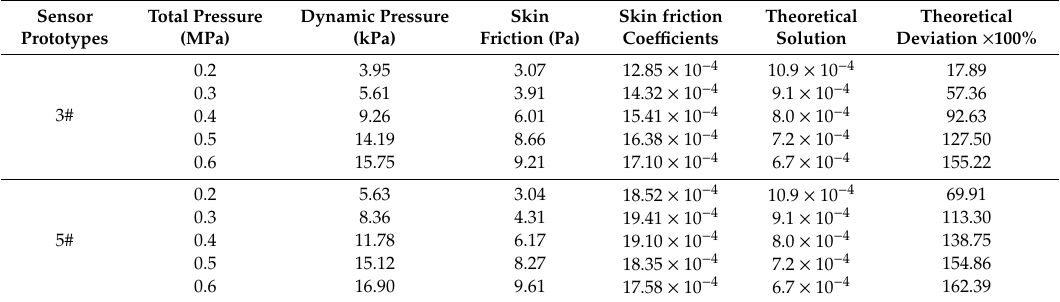
Table 7. The data analysis of dynamic calibration under laminar flow conditions.